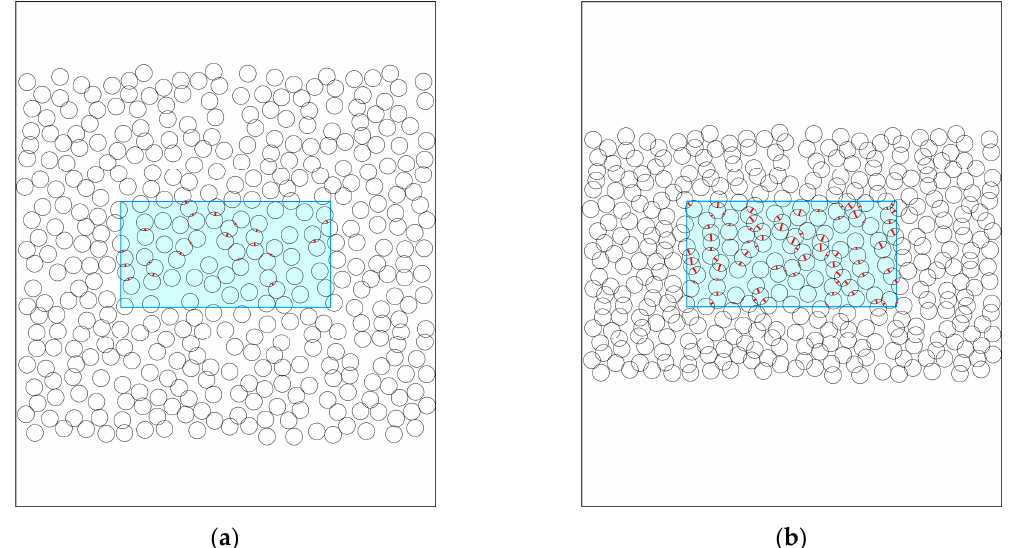
Figure 5. Cross-sectional analysis at compression ratios of ( a ) 0.75 and ( b ) 0.5. The overlap length is shown by red lines.